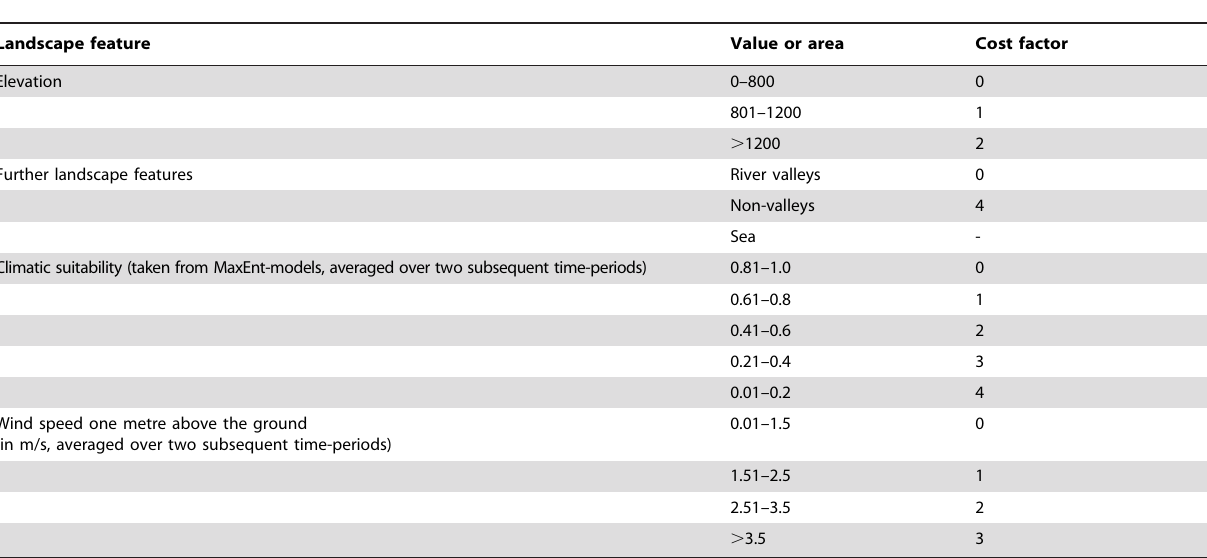
Table 2. Cost factors within the defined cost surfaces for Phlebotomus